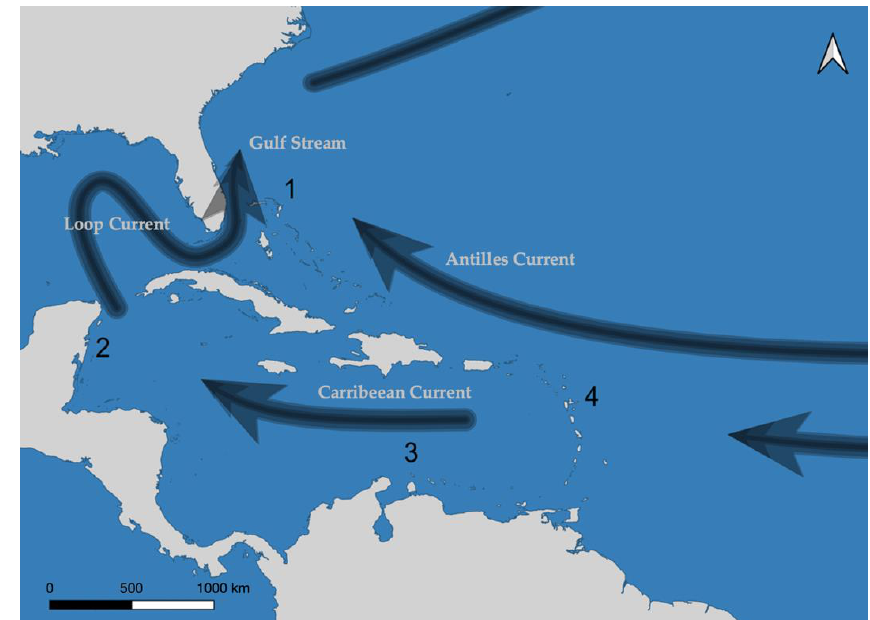
Figure 1. Major surface ocean current flow, with numbered labels of regions. Across these areas, ocean currents and island configurations result in different connectivity regimes. Bahamas (1) and Belize (2) have strong, complex connectivity regimes, with dense clusters of islands and the former subject to converging currents of the Gulf Stream and the Antilles Current. The Lesser Antilles (4) consists of a chain islands with north westerly ocean currents. Bonaire (3) is comprised of a disparate series of islands and is subjected to lateral, westerly currents from the Caribbean Current. Note that the oceanographic model is far more complex than illustrated here.